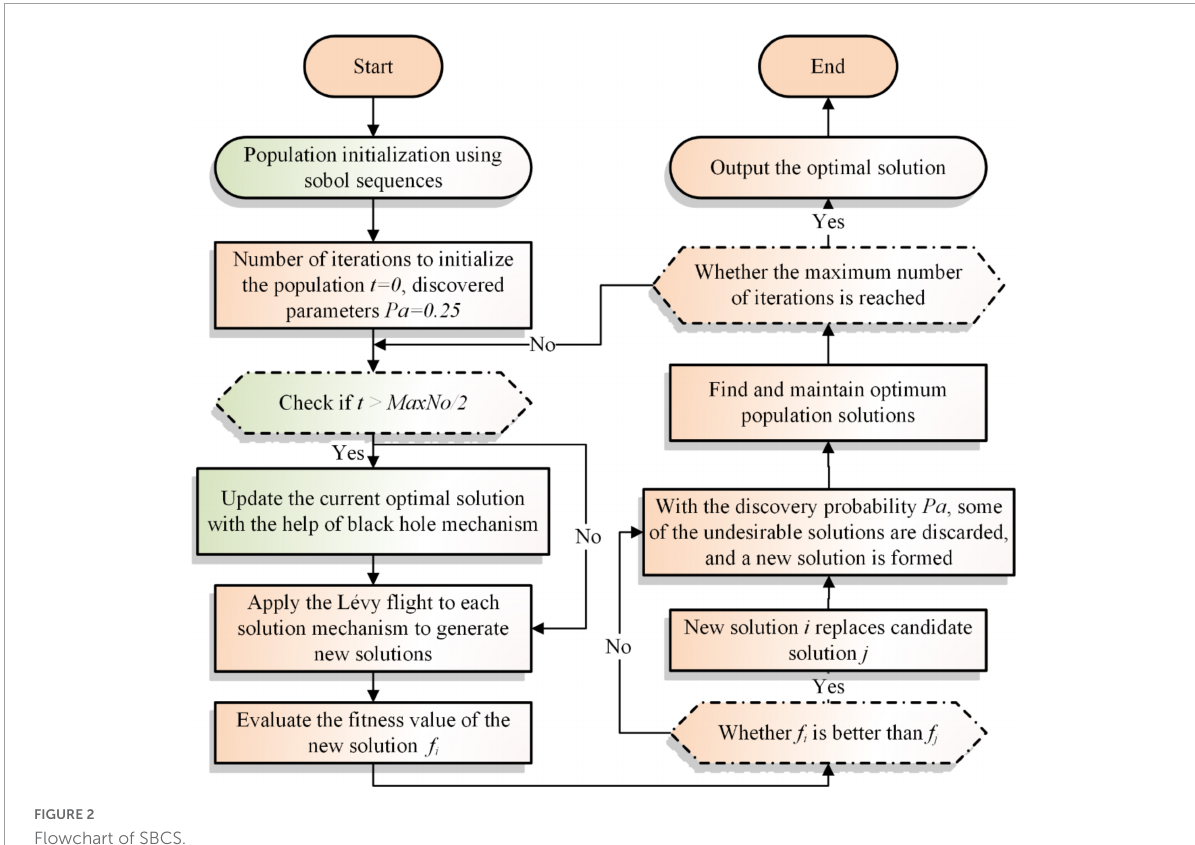
FIGURE2 Flowchart of SBCS.